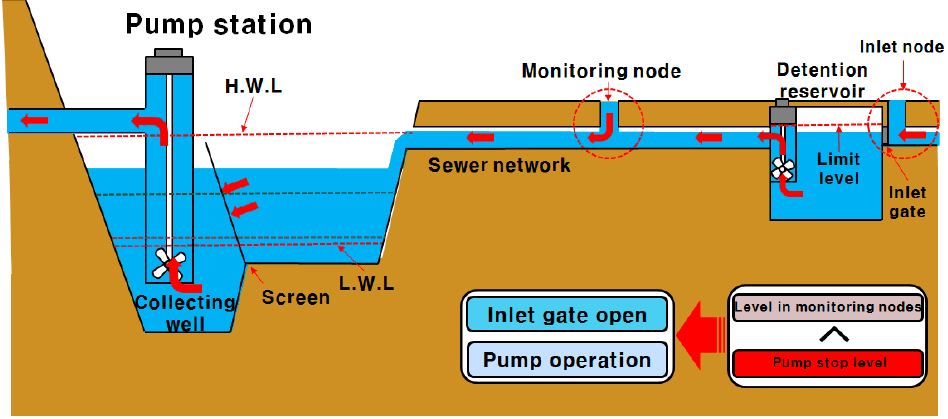
Figure 2. Structure of a DR in an urban drainage system.